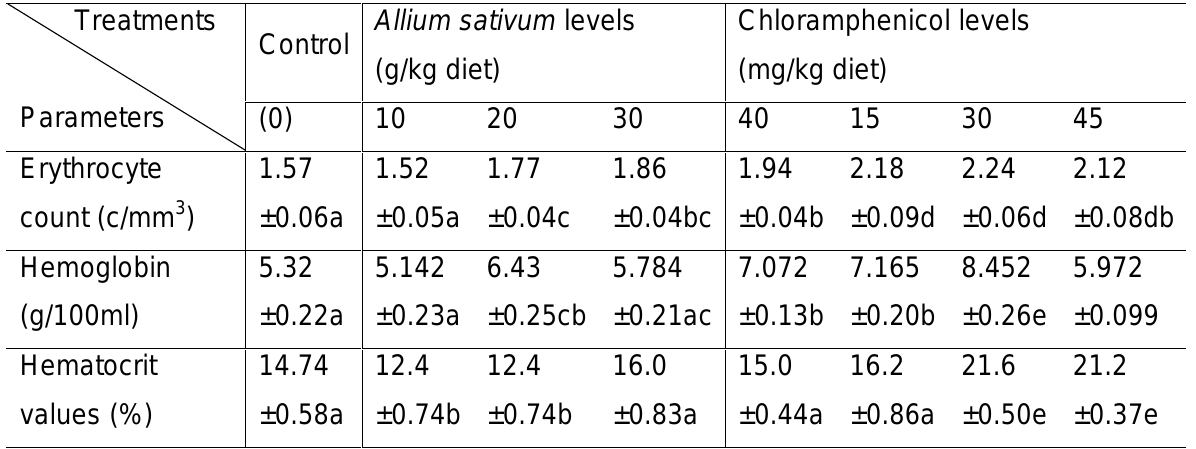
Table 5: Erythrocytes count, hemoglobin, and hematocrit values of O. niloticus fed on diets containing different levels of Allium sativum and chloramphenicol.